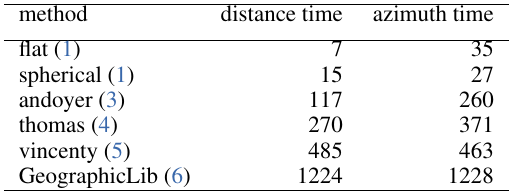
Table 2. Average timings for 150000 geodesics in nsec (100 runs for each geodesic).